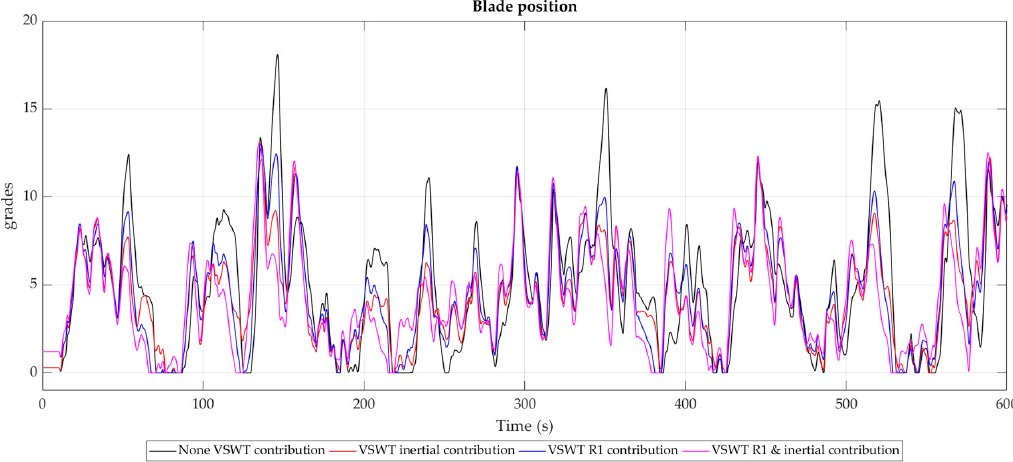
Figure 8. Blade position in the cases none VSWT contribution, VSWT inertial contribution, R1 contribution and R1 and inertial contribution (5% power reserve), respectively.